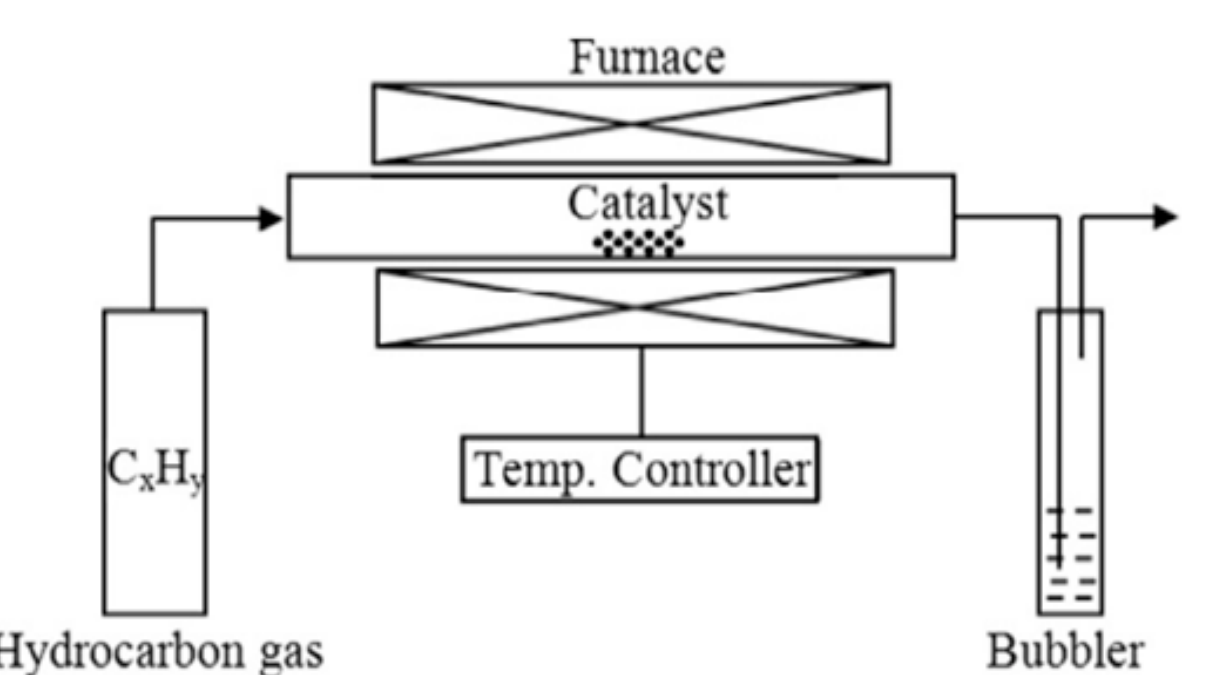
Figure 2. Schematic presentation of a CVD setup (image reproduced from reference [27], which was published under a creative common attribution (CC BY) license).